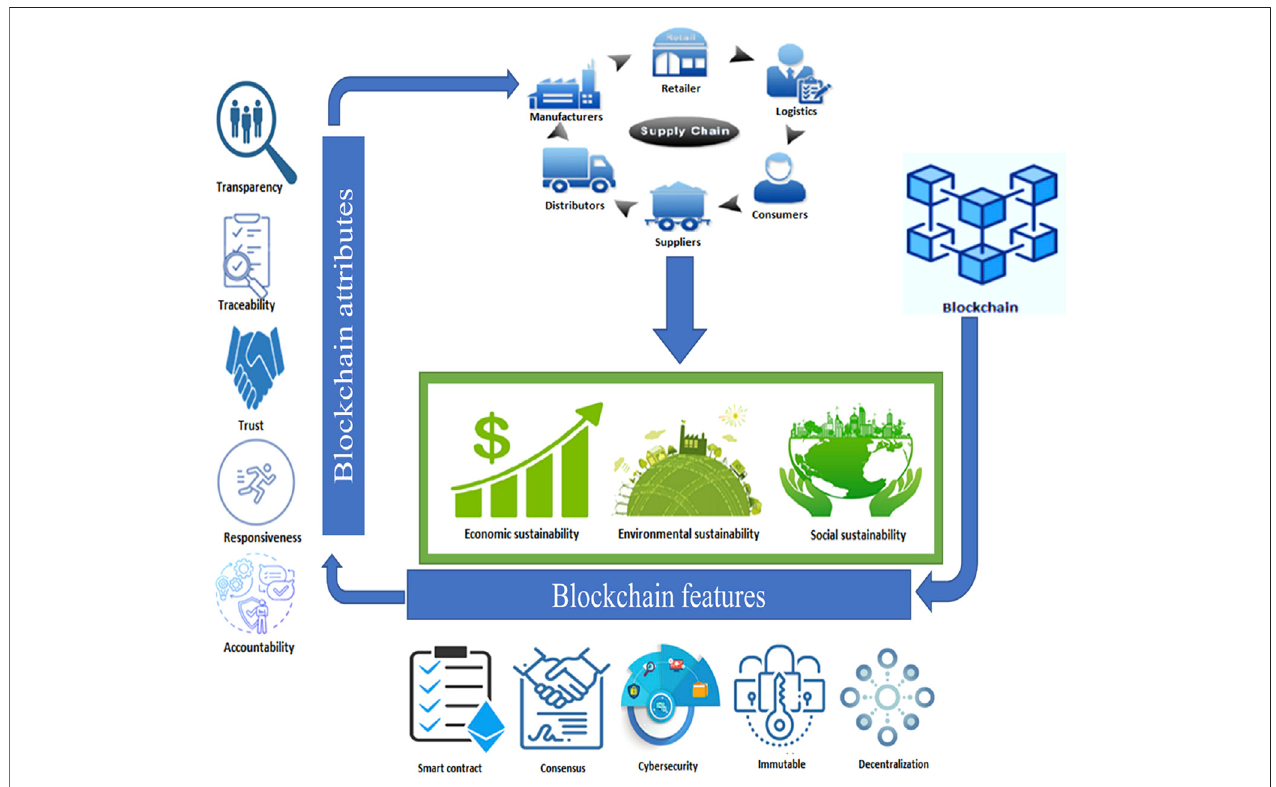
FIGURE 2 | Conceptual framework of transformation of the supply chain to attain triple bottom line through blockchain.